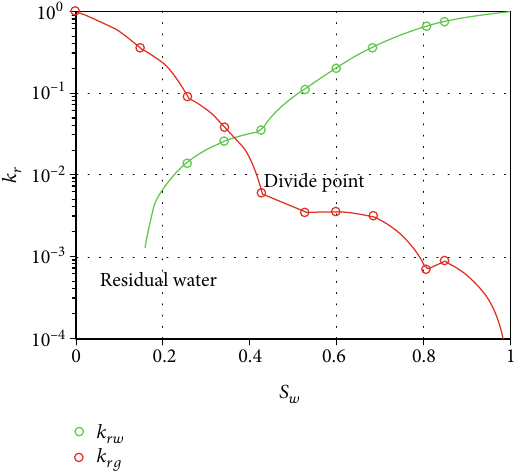
Þ and water ð k rg Þ w